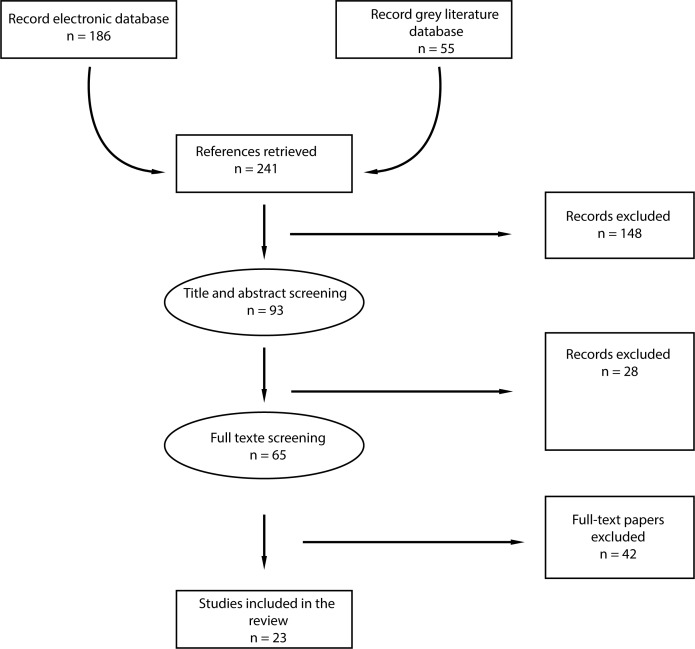
“PRISMA” flowchart.